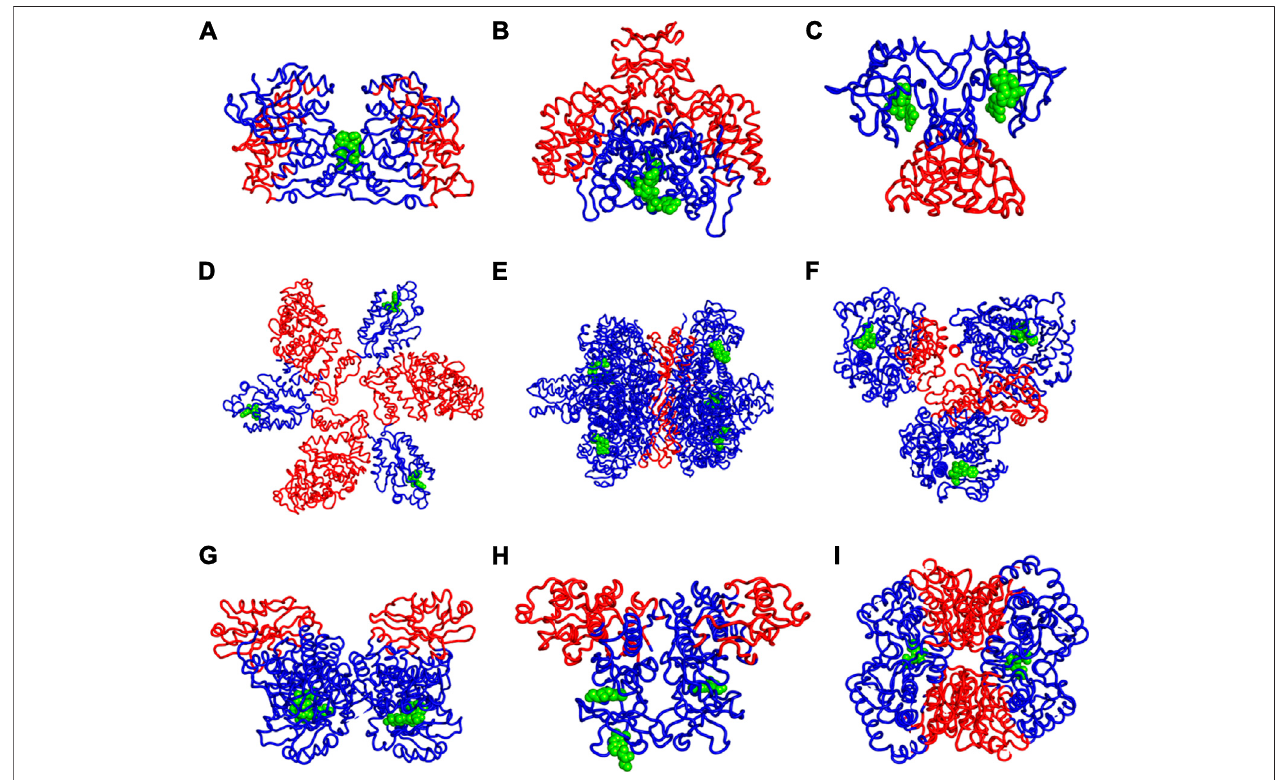
FIGURE3| Increases(red)andDecreases(blue)inFuctuationsuponLgand(greenspheres)Bindingin (A) Mitogen-activatedproteinkinase8, (B) Citratesynthase, (C) Uncharacterized protein VCA0042, (D) ATP sulfurylase, (E) Glutamate dehydrogenase, (F) Acetyl-Coenzyme A carboxylase, (G) Isocitrate dehydrogenase kinase/ phosphatase, (H) Casein kinase II subunit alpha, (I) l-lactate dehydrogenase. While there appears to be a large variety of positions that are affected, the universal rule appears to be that the part of the structure furthest away from the binding site has the largest increases in fl uctuations. If the binding site is near the outside of the protein, then the largest increases in fl uctuations will be at the center of the protein. One particularly interesting such case is shown in part d where there are three occupiedbindingsites,whichcanbepresumed,eachtoincreasethe fl uctuationsinthemostdistantpartsowiththethreeoccupiedbindingsitesallthreedomainshave increased fl uctuations near the center of the overall